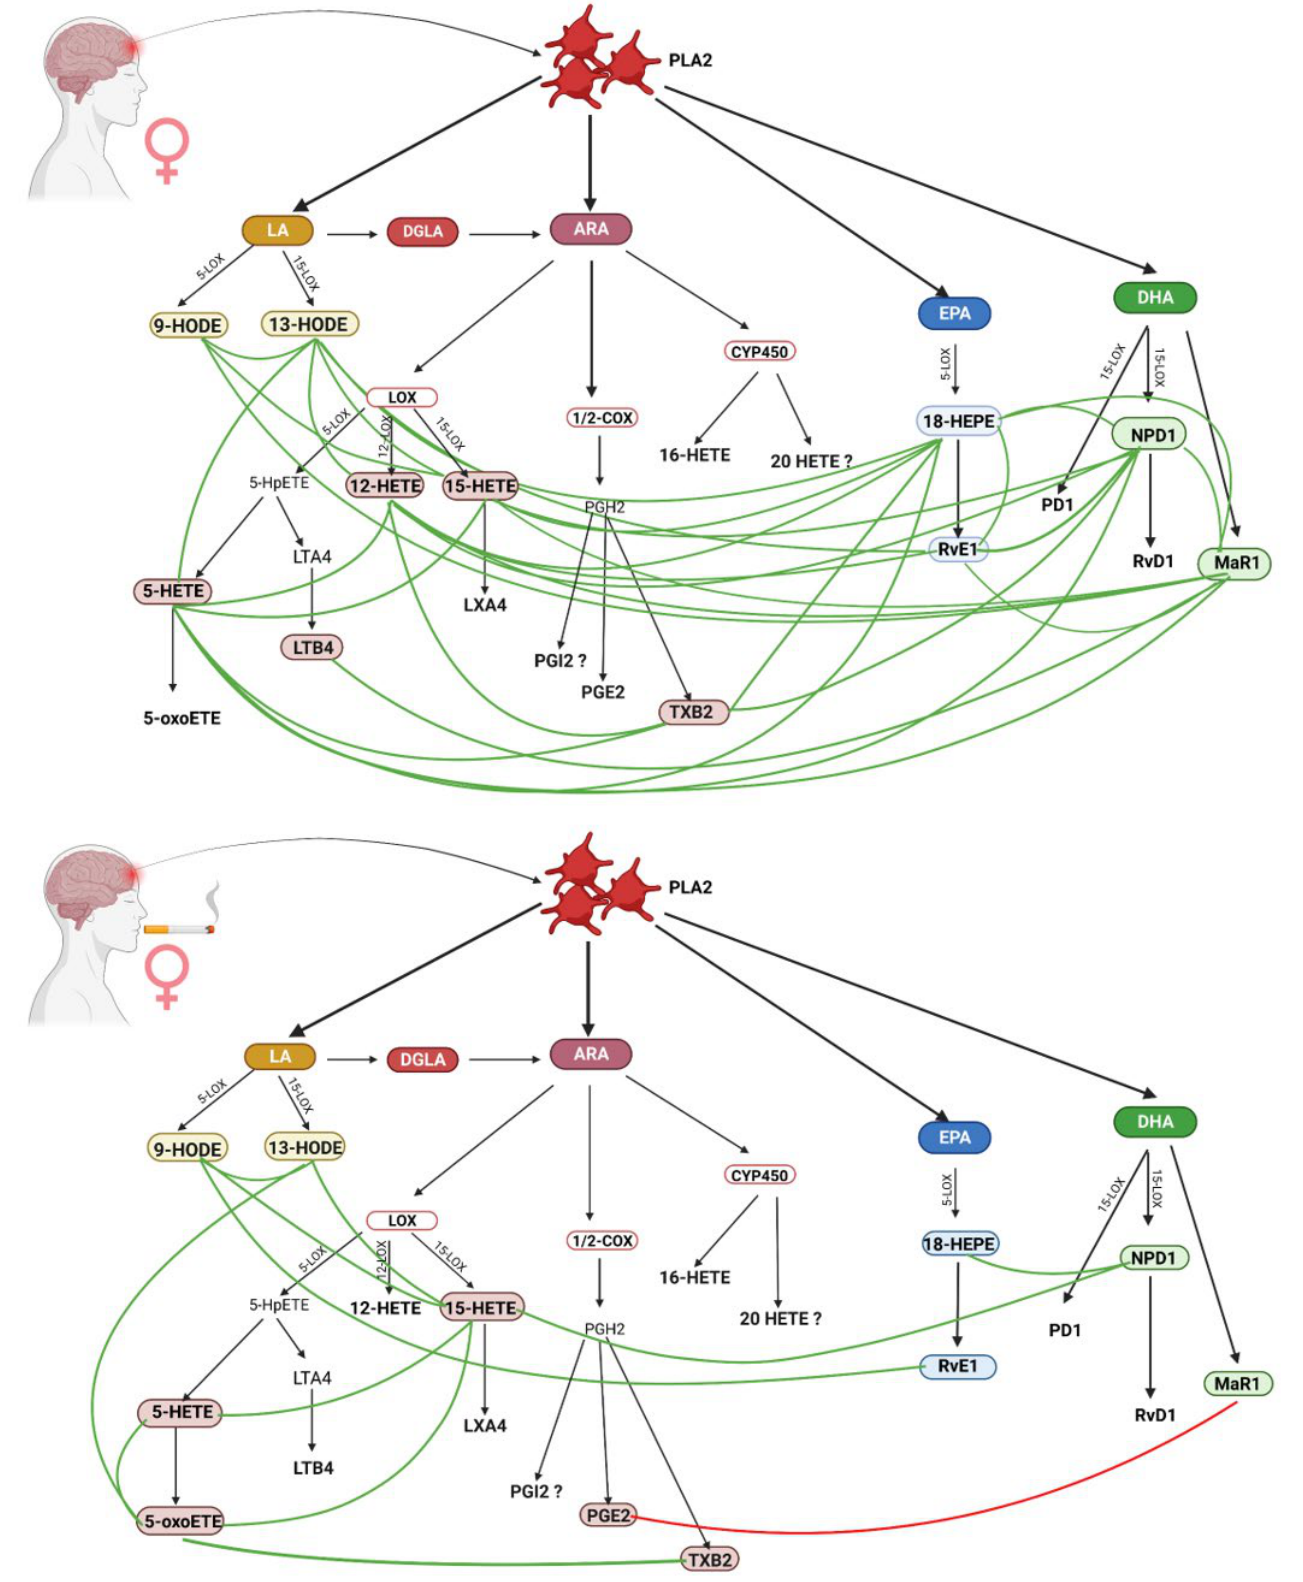
Figure 2. Comparison of inflammatory response in female non-smokers and female smokers. (Created with BioRender.com https://app.biorender.com/; accessed on 30 September 2022).